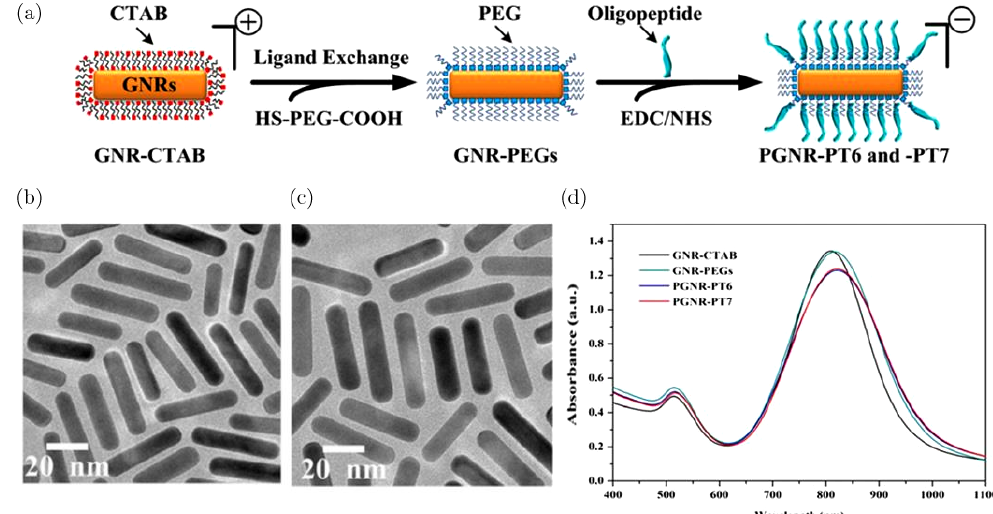
Fig. 2. (a) Synthesis of PEGylated GNRs with PT6 and PT7 oligopeptides. (b) and (c) TEM images of the PEGylated GNRs after modi¯cation with PT6 and PT7. (d) UV – Vis-NIR absorbance spectra of GNRs before (GNR-CTAB) and after PEGylation (GNR- PEGs) and oligopeptide conjugation (PGNR-PT6 and -PT7).